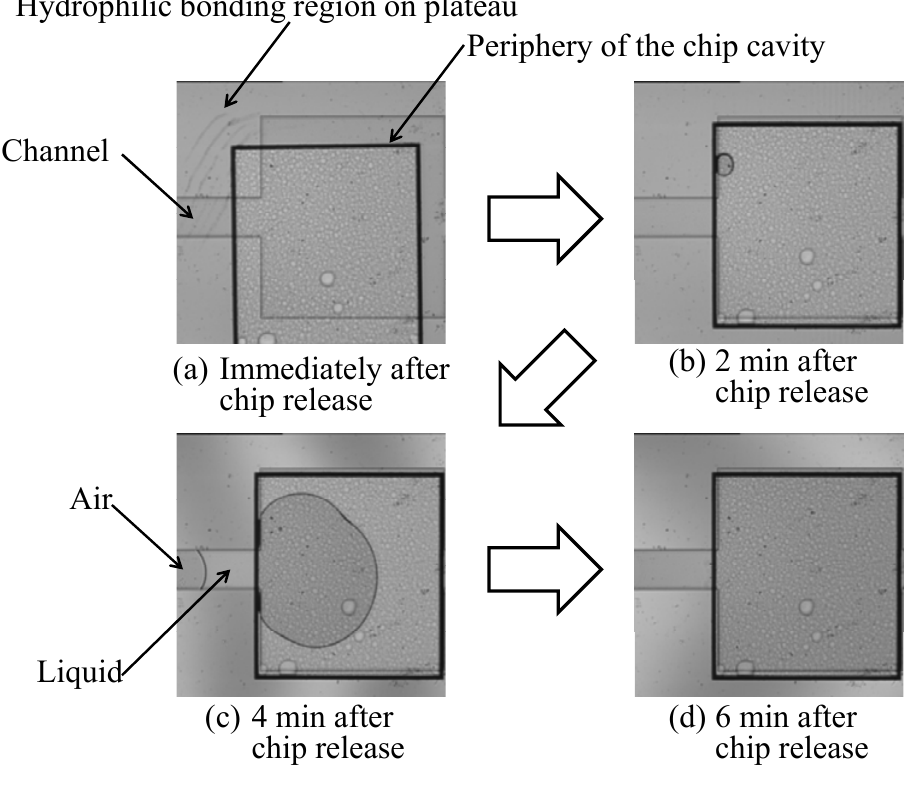
Figure 7. IR transmission images of a self-assembling chip having one cavity and evaporating liquid through a channel formed on a Si